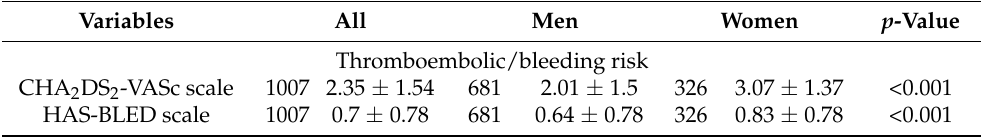
Table 5. Thromboembolic and bleeding risk scores.